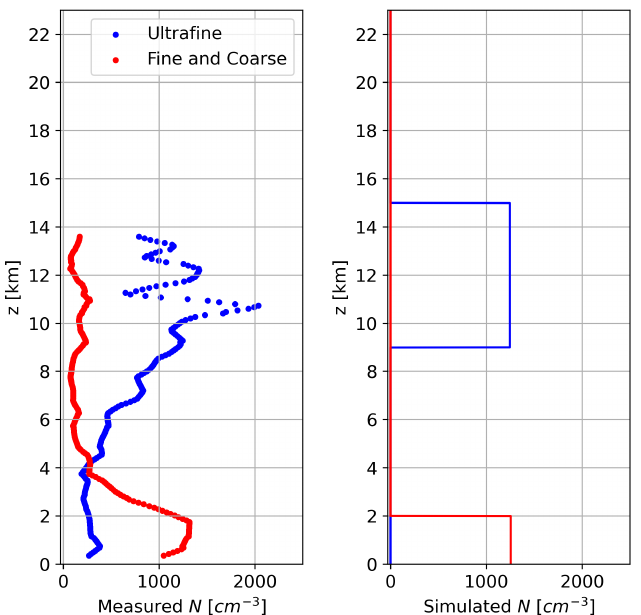
Figure 1. Median aerosol number concentrations measured by the HALO aircraft ( left ) and the 2-layer representation adopted in our simulations ( right ), for the ultrafine (blue) and fine plus coarse particles (red). The values shown are not corrected for standard temperature (273.15K) and pressure (1000hPa).